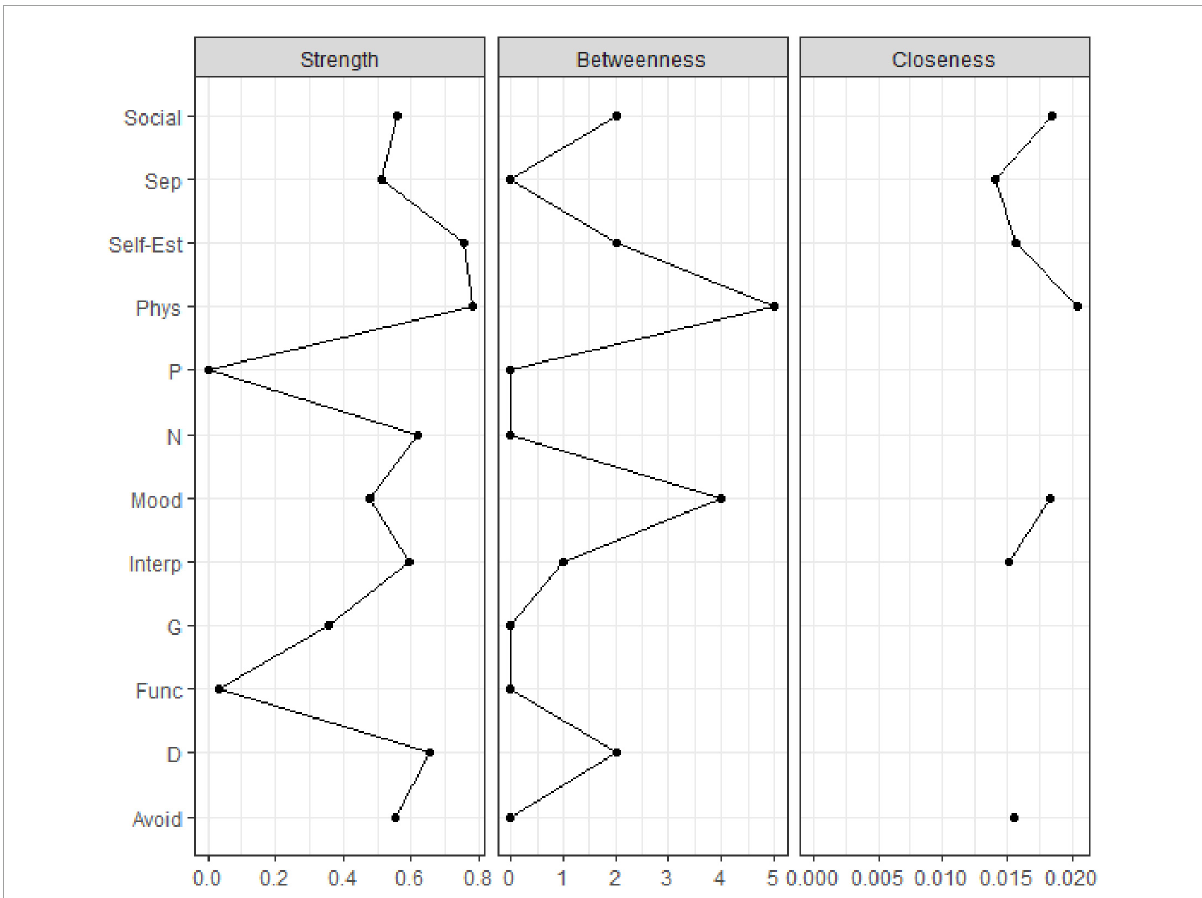
FIGURE3 Centrality indices of the study variables within the network. Centrality indices (i.e., node strength, closeness, betweenness) are shown as standardized z